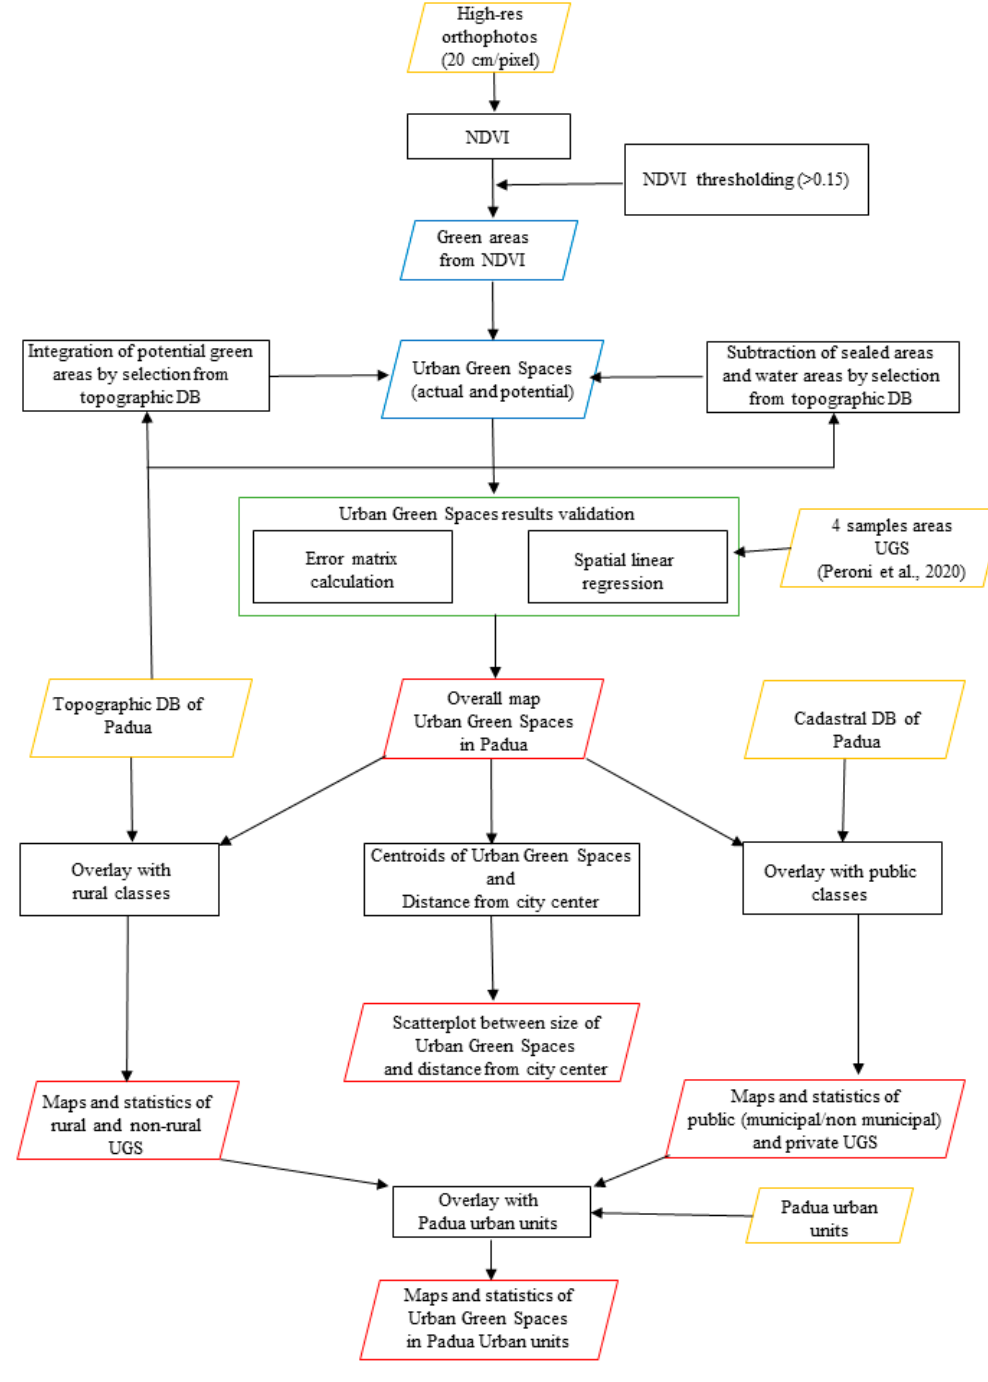
Figure 3. Overall flowchart showing the main methodologies (black boxes), data inputs (yellow boxes), urban green spaces validation (green box), and outputs (red